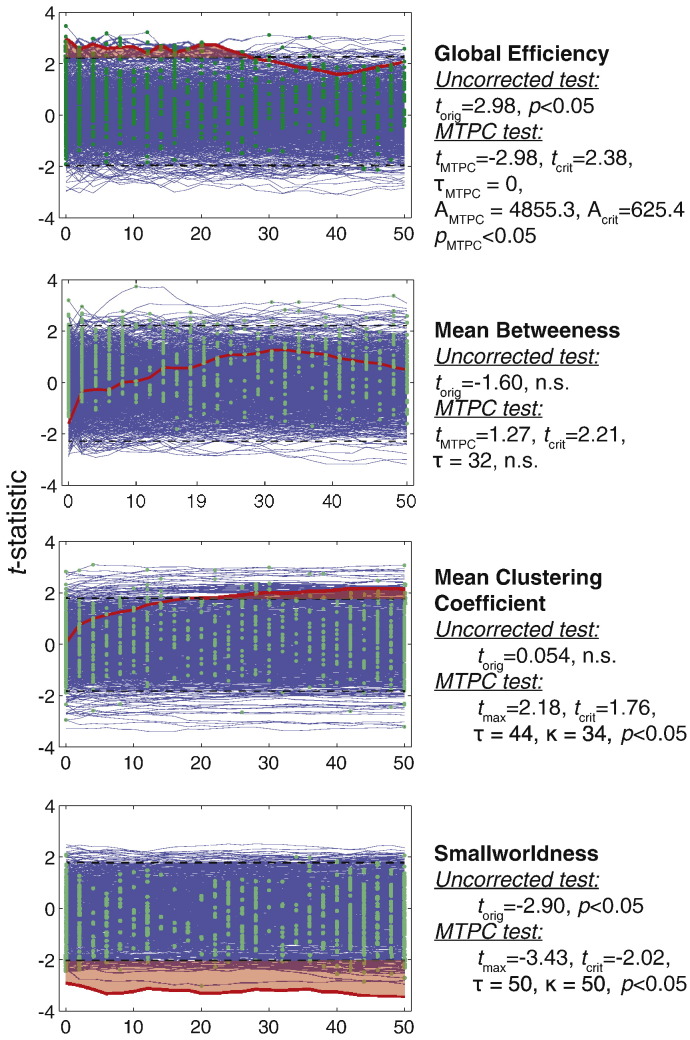
MTPC applied to the statistical tests using the data of (Caeyenberghs et al., 2014).